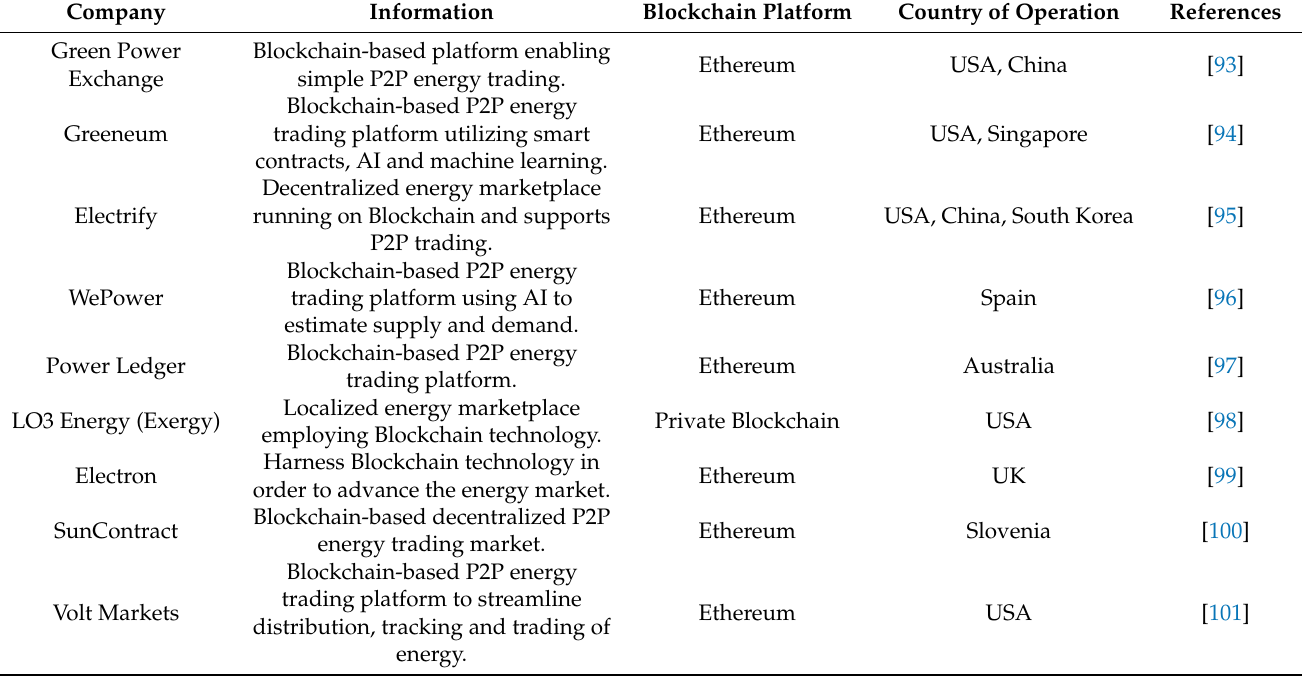
Table 3. Companies employing Blockchain technology for energy